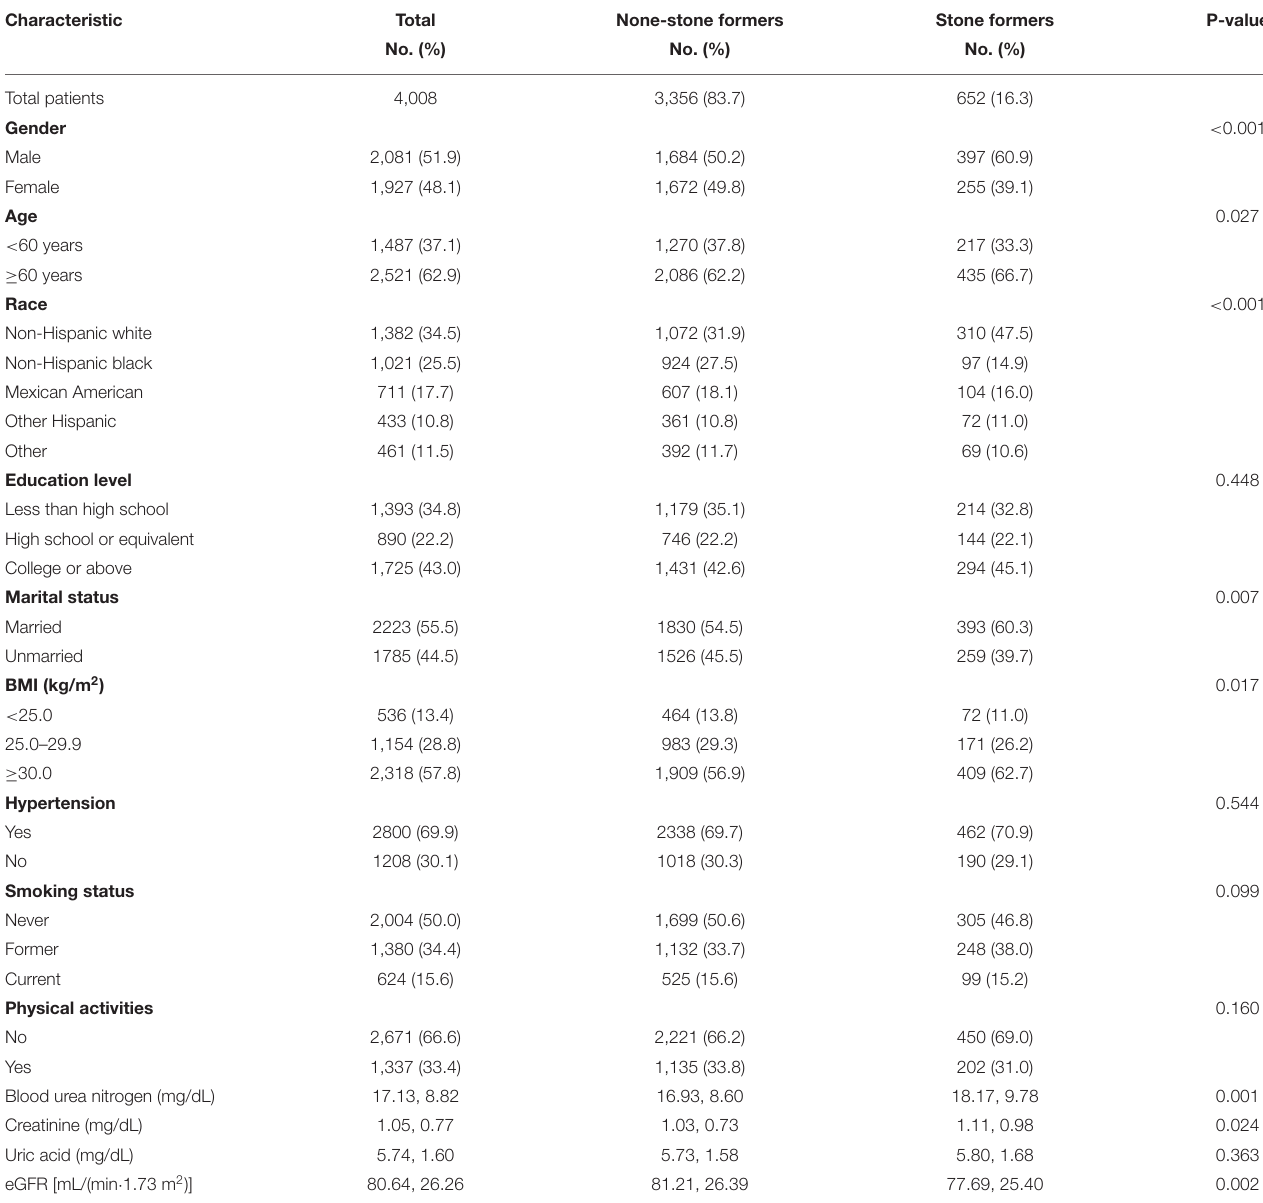
TABLE 1 | Baseline characteristics of diabetes participants between 2007 and